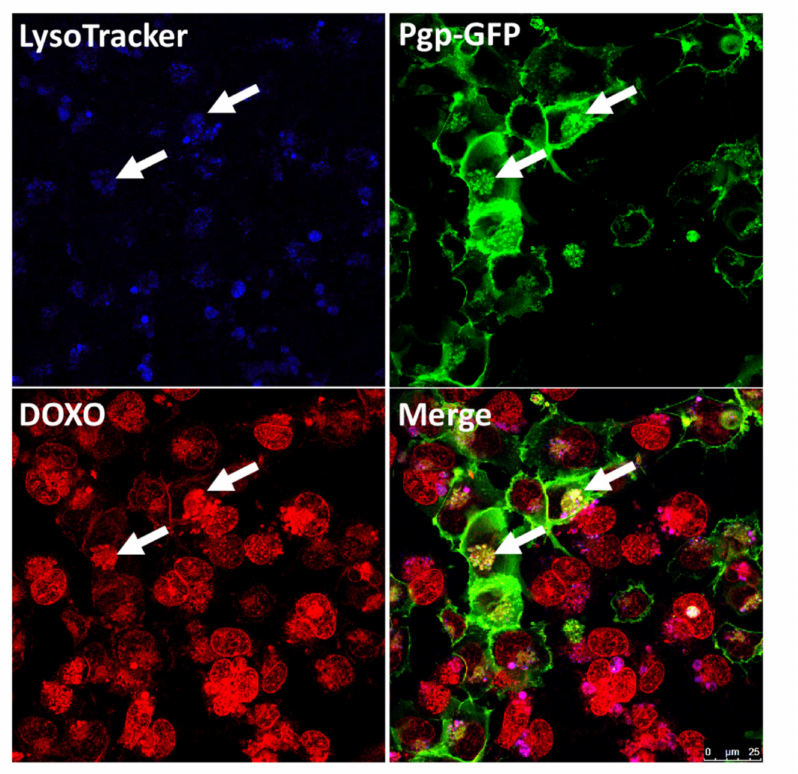
Figure 5. Sequestration of doxorubicin (DOXO) into Pgp-EGFP positive endolysosomal vesicles in hCMEC / D3 cocultures. After confluency, hCMEC / D3 cocultures (equal amounts of WT and MDR1 -EGFP transduced cells) were incubated with the blue fluorescent dye LysoTracker Blue DND-22 (75 nm, 1 h, 37 ◦ C) to label acidic endolysosomal compartments, followed by treatment with the Pgp substrate DOXO (10 µ M, 30 min, 37 ◦ C), which is visible in red by its autofluorescent character. Cells were subsequently analyzed by live-cell imaging and confocal microscopy. Arrows indicate the DOXO sequestration into endolysosomal Pgp-EGFP (green staining) enriched compartments within the brain capillary endothelial cells. Unpublished figure from B.